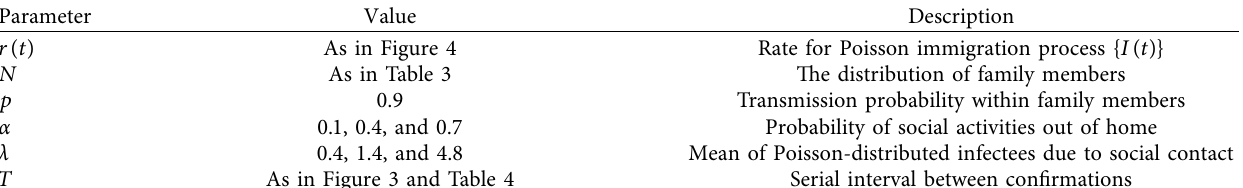
Table 5: Parameters or variables’ descriptions with values or distributions for our model.